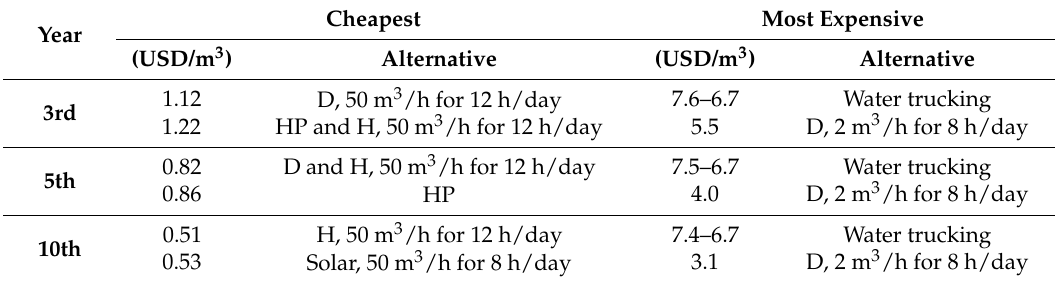
Table 4. Overview of the cheapest and most expensive (USD/m 3 ) alternatives in the third, fifth and tenth years of operation. D: Diesel; HP: Hand pump; H: Hybrid. Discount rate = 0%. Details in Supplementary Material